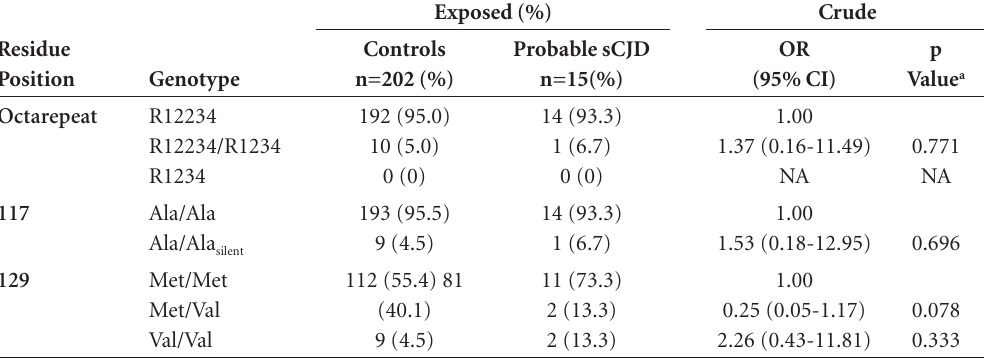
Table 6. PRNP polymorphisms in probable sCJD cases compared to the other notified cases. Residue